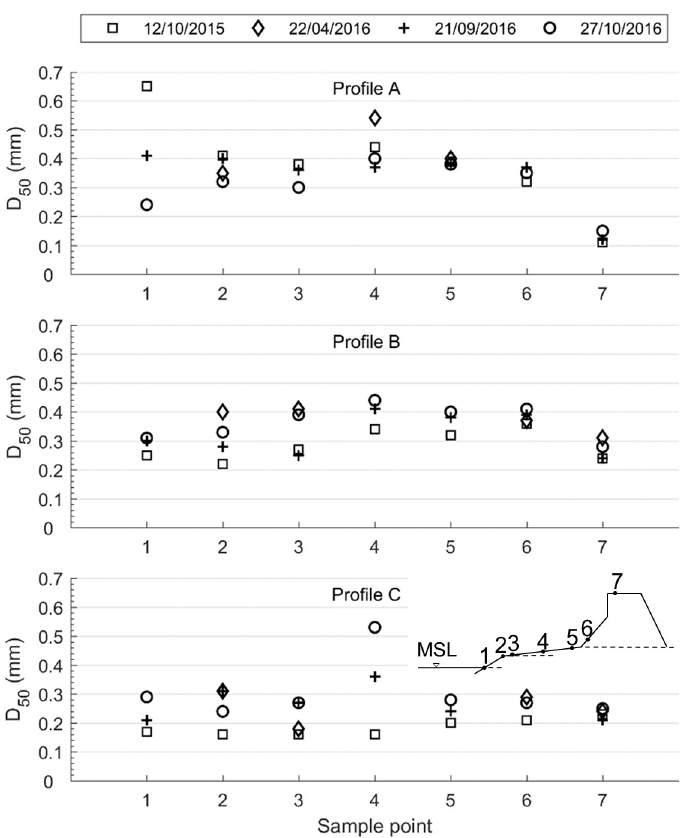
Fig 11. Median grain size D 50 for sediment samples in Profile A, B, and C sampled from the shoreline (1) to the dune crest